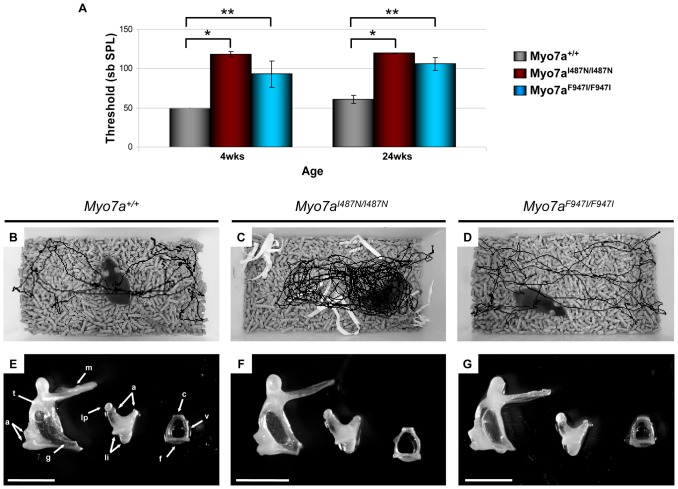
Phenotypic observations of Myo7a mutant strains.(A) Hearing profile of Myo7a+/+, Myo7aI487N/I487N ewaso and Myo7aF947I/F947I dumbo strains at 4 weeks (*p = 2.2×10−25, **p = 4.5×10−10) and 24 weeks (*p = 3.7×10−29, **p = 7.2×10−20). (B–G) Video surveillance and middle ear morphology in Myo7a strains. Observations highlighted an increased number of turns in Myo7aI487N/I487N ewaso mice (C), when compared to wild-type (B). No such behaviour was seen in Myo7aF947I/F947I dumbo mutants (D). Middle ear bones appear largely normal in Myo7aI487N/I487N ewaso (F) and Myo7aF947I/F947I dumbo (G) mutants, comparable to normal morphology of the malleus, incus and stapes (E). M; manubrium of malleus, A; articulation surfaces of malleus and incus joint, T; tubercle, G; gonial angle, LI; attachment points of suspensory ligaments of incus, LP; lenticular process, C; capitulum of stapes, V; arched ventral crus, F; footplate. Scale bar; 1 mm (E–G).